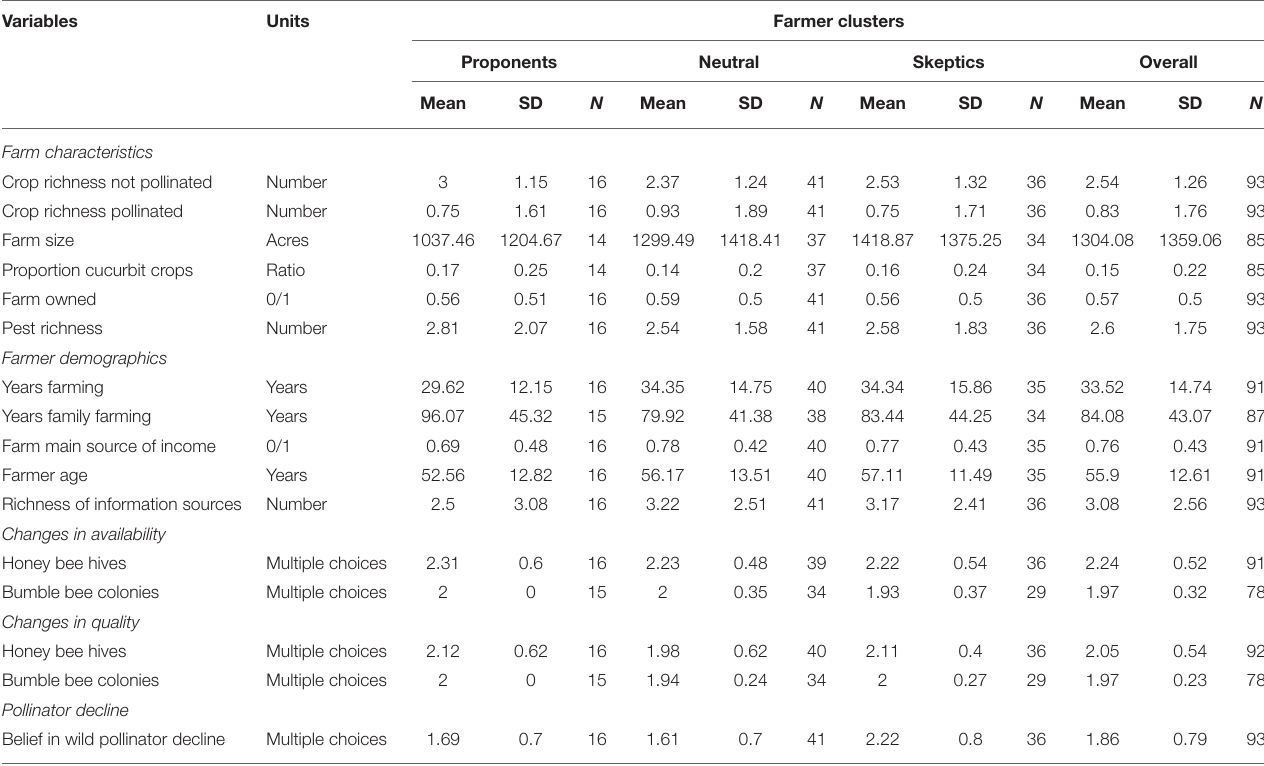
TABLE 1 | Qualitative assessment of farmer classes including their farm characteristics, demographics, perceptions of the changes in quality and availability of managed honey bee hives and bumble bee colonies, and belief in pollinator declines.